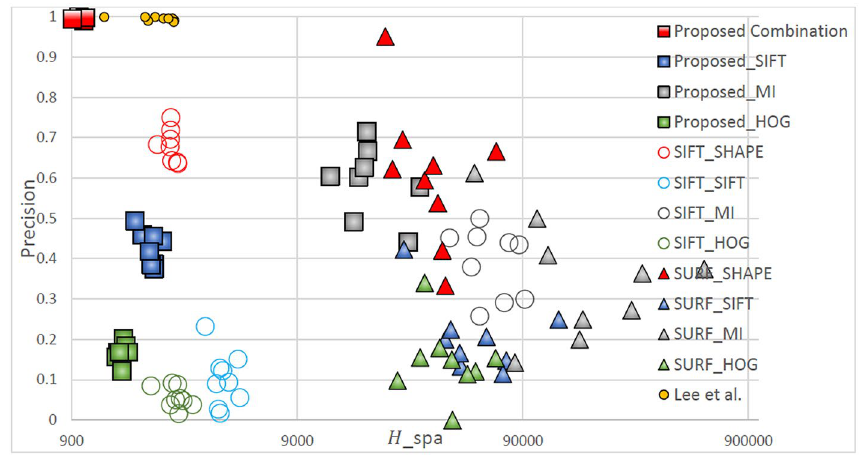
Figure 8. Quantitative comparison of matching in TYPE IV through different matching